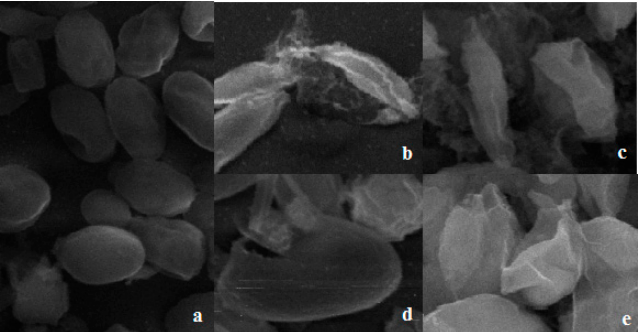
Figure 2. Effects of microwave heating on B. braunii : ( a ) control sample, ( b ) series I, ( c ) series II, ( d ) series III, ( e ) series